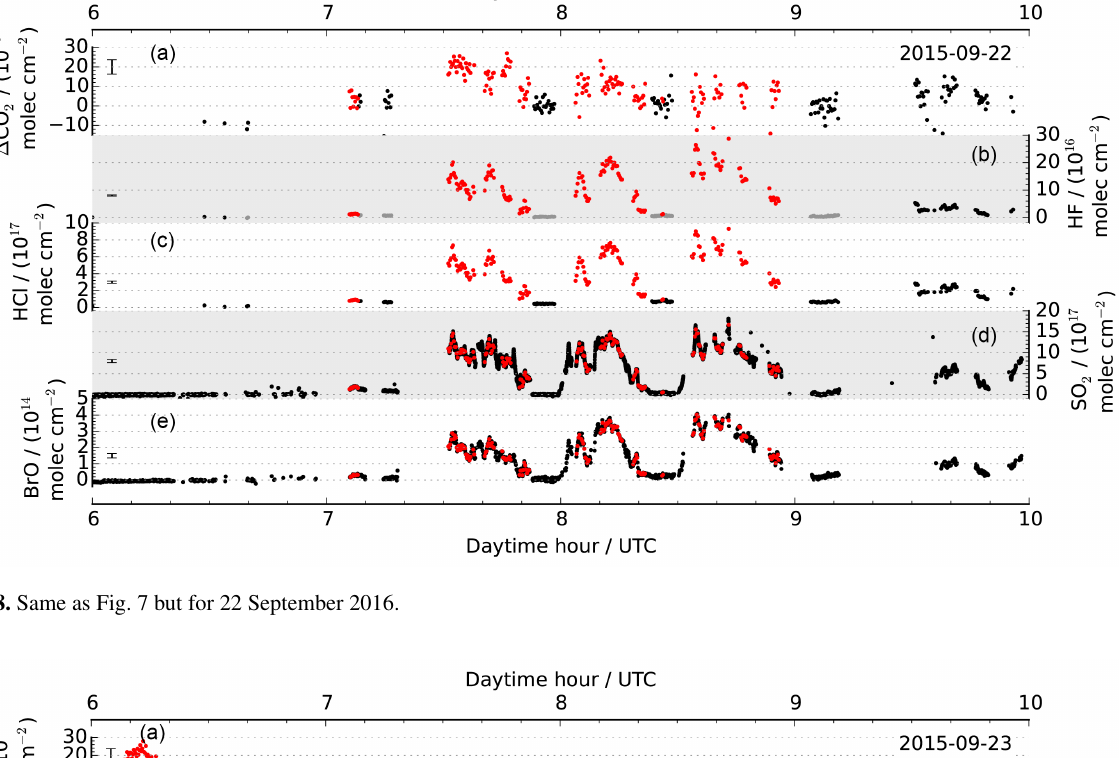
Figure 8. Same as Fig. 7 but for 22 September 2016.